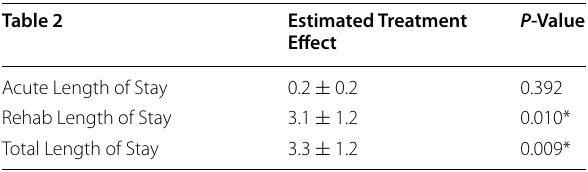
*Indicates statistical significance